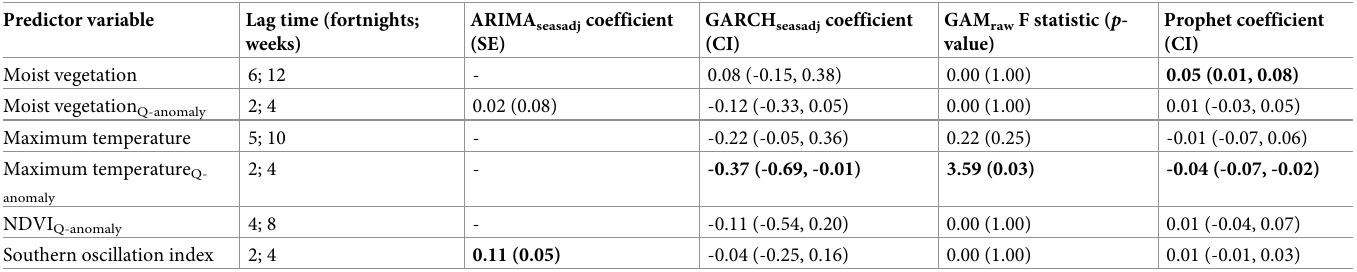
Table 2. Summary statistics for predictor coefficients. All predictors were scaled to unit variance prior to modelling. Significant effects are highlighted in bold. Note that GAM F statistics only indicate the nonlinearity of the estimated smooth function, not the directionality of the effect. ARIMA, Autoregressive Integrated Moving Aver- age; GARCH; Generalized Autoregressive Conditional Heteroskedasticity; GAM, Generalized Additive Model. SE, standard error; CI, Bayesian credible